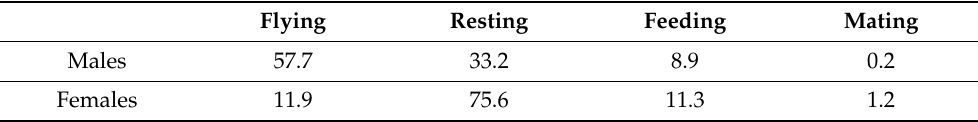
Table 4. Percentage of individuals of Erebia pronoe in four different behavioural categories, divided by